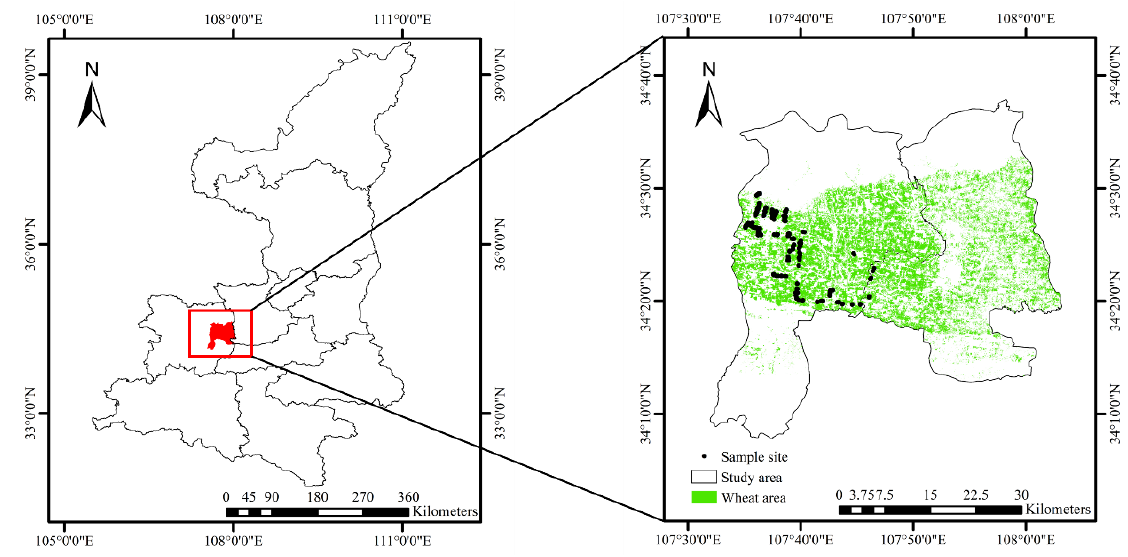
Figure 1. Overview map of the study area.